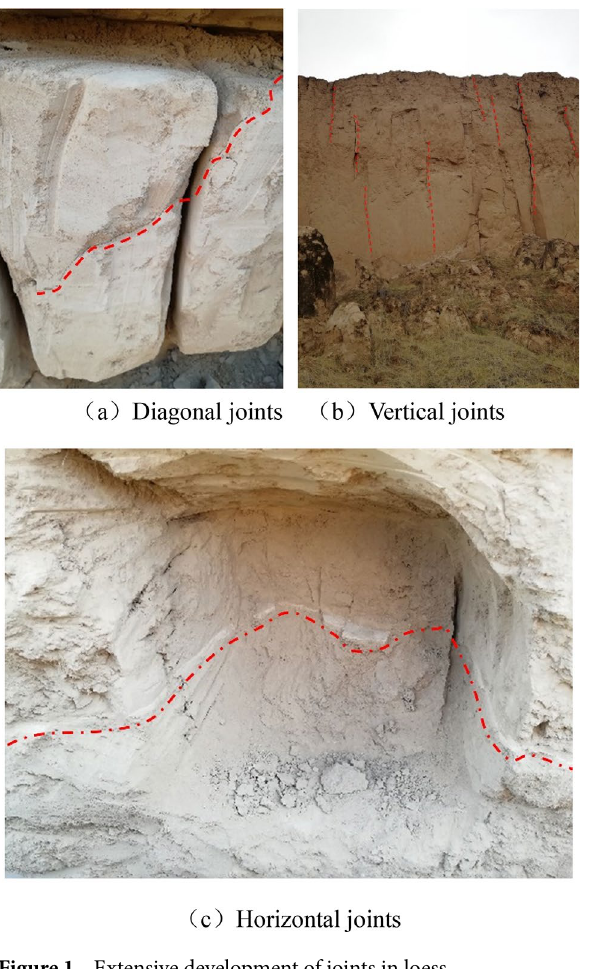
Figure 1. Extensive development of joints in loess.